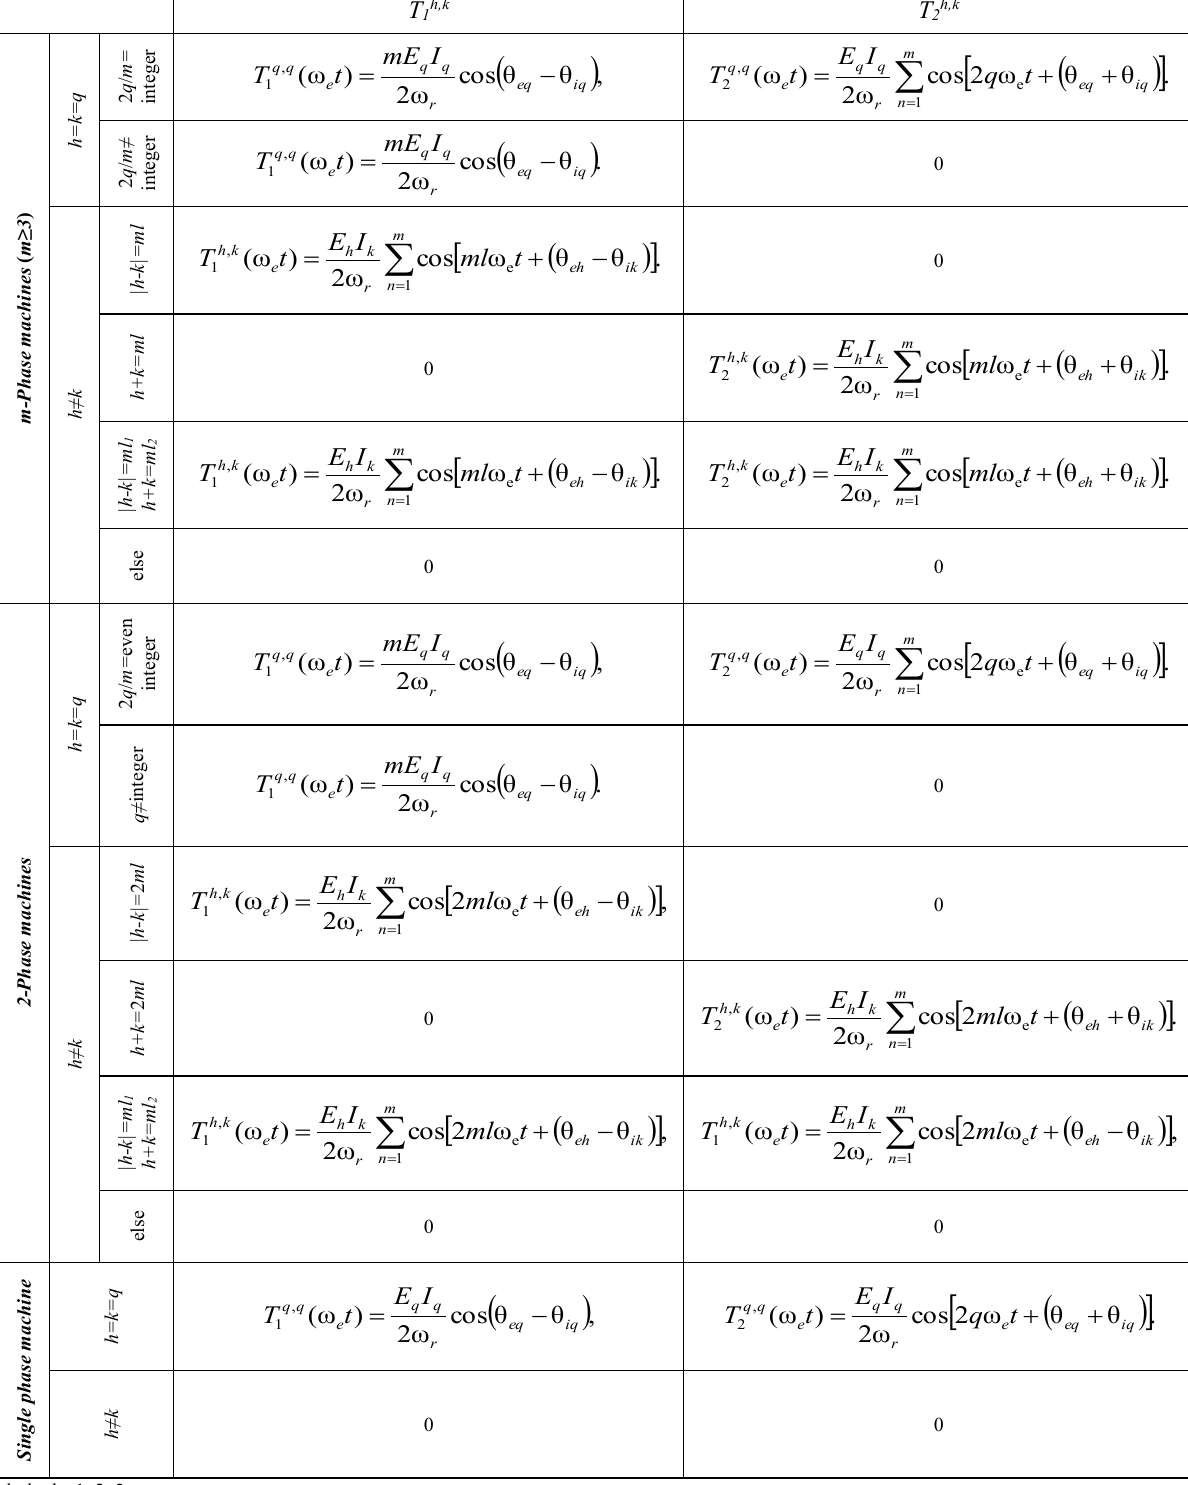
Table 1: The electromagnetic torque equations based on different scenarios for harmonics pair of internal voltage and phase current T 1h,k T